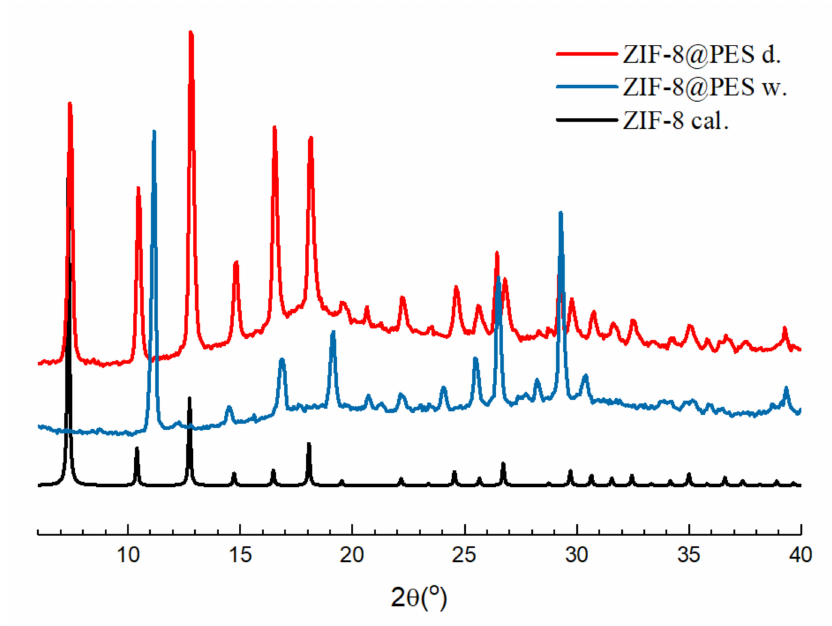
Figure 3. Powder pattern of ZIF-8 membrane prepared using di ff erent